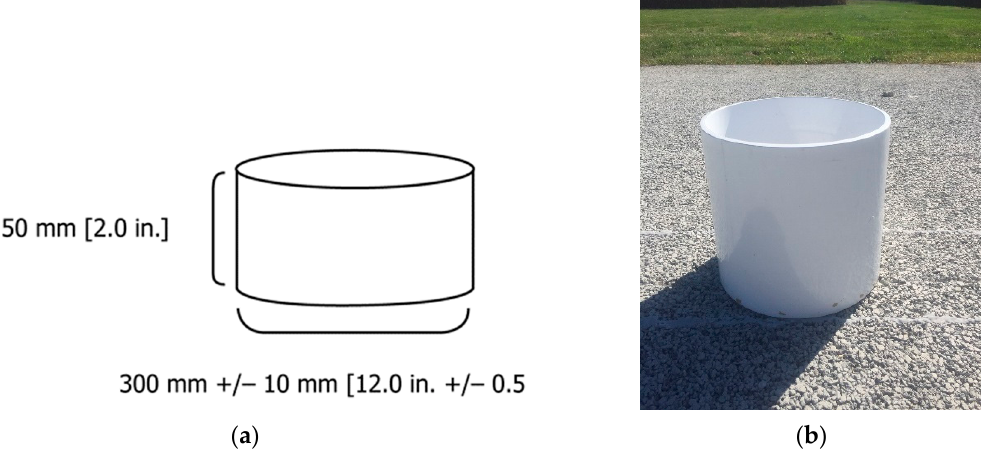
Figure 7. ( a ) Dimensions of infiltration ring described in ASTM C1701/C1701M and ASTM C1781/C1781M [62,63], and ( b ) the cylinder ring used in this study.